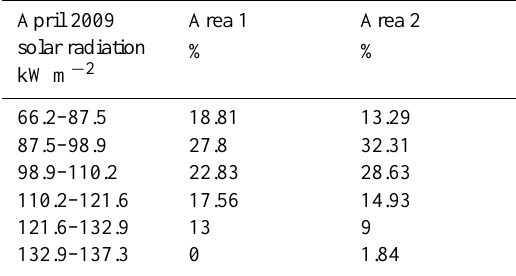
Table 6. Distribution of shallow landslide source areas in relation to April 2009 potential solar